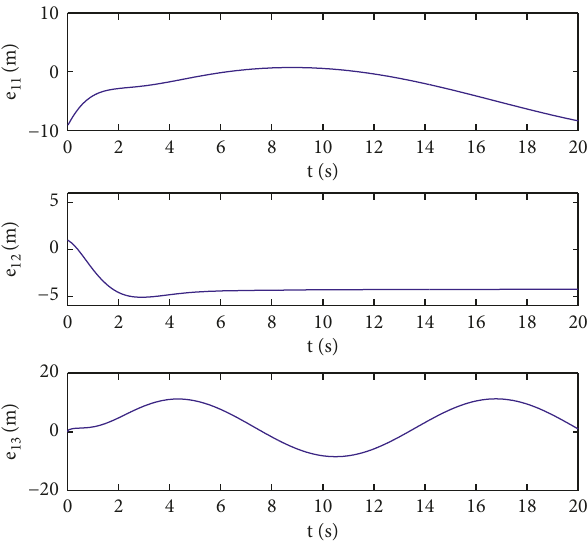
without robust FTC. 1 i